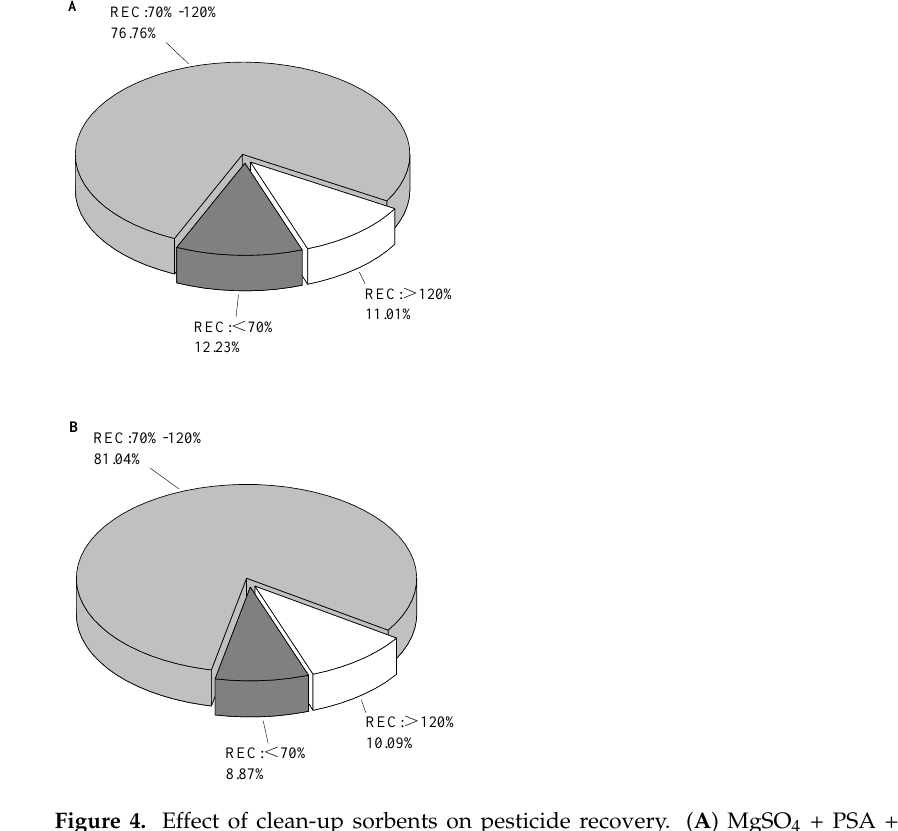
Figure 4. Effect of clean-up sorbents on pesticide recovery. ( A ) MgSO 4 + PSA + C18 + Z-sep; ( B ) ( B ) MgSO 4 + PSA + MgSO 4 + PSA + C18.